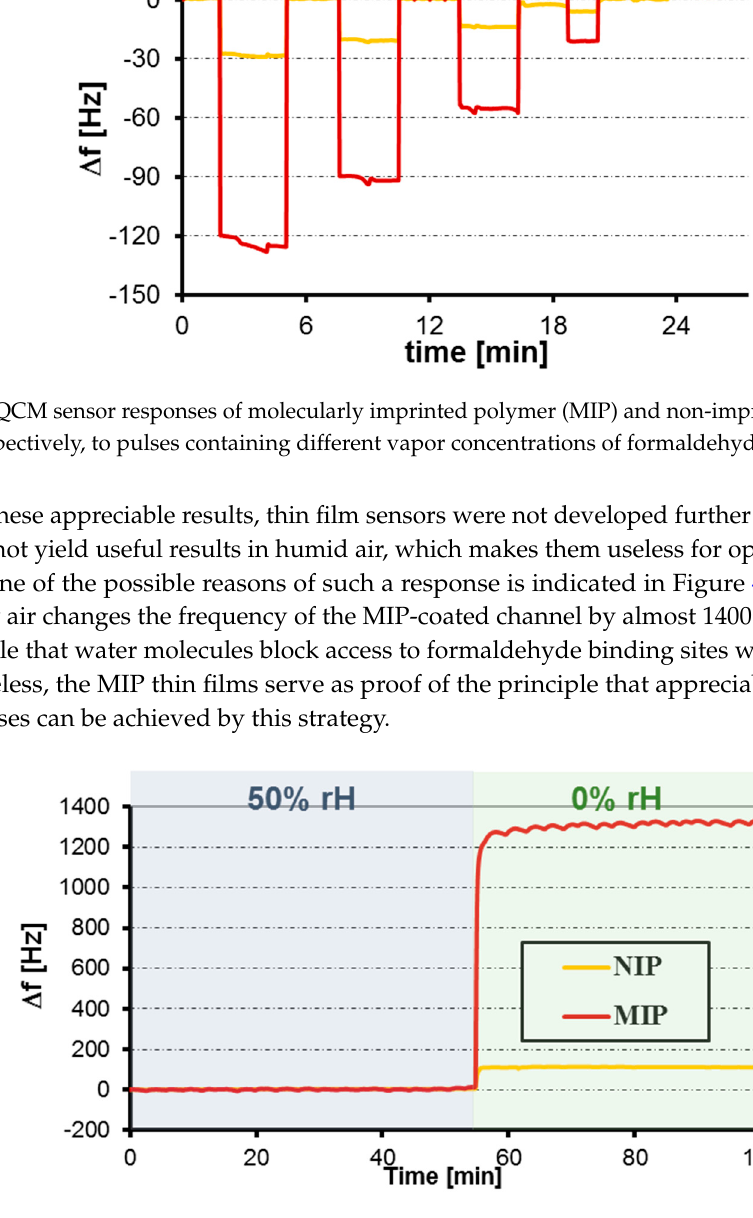
Figure 4. Sensor responses of MIP and NIP, respectively, when switching from an air stream with 50% rH to dry air.